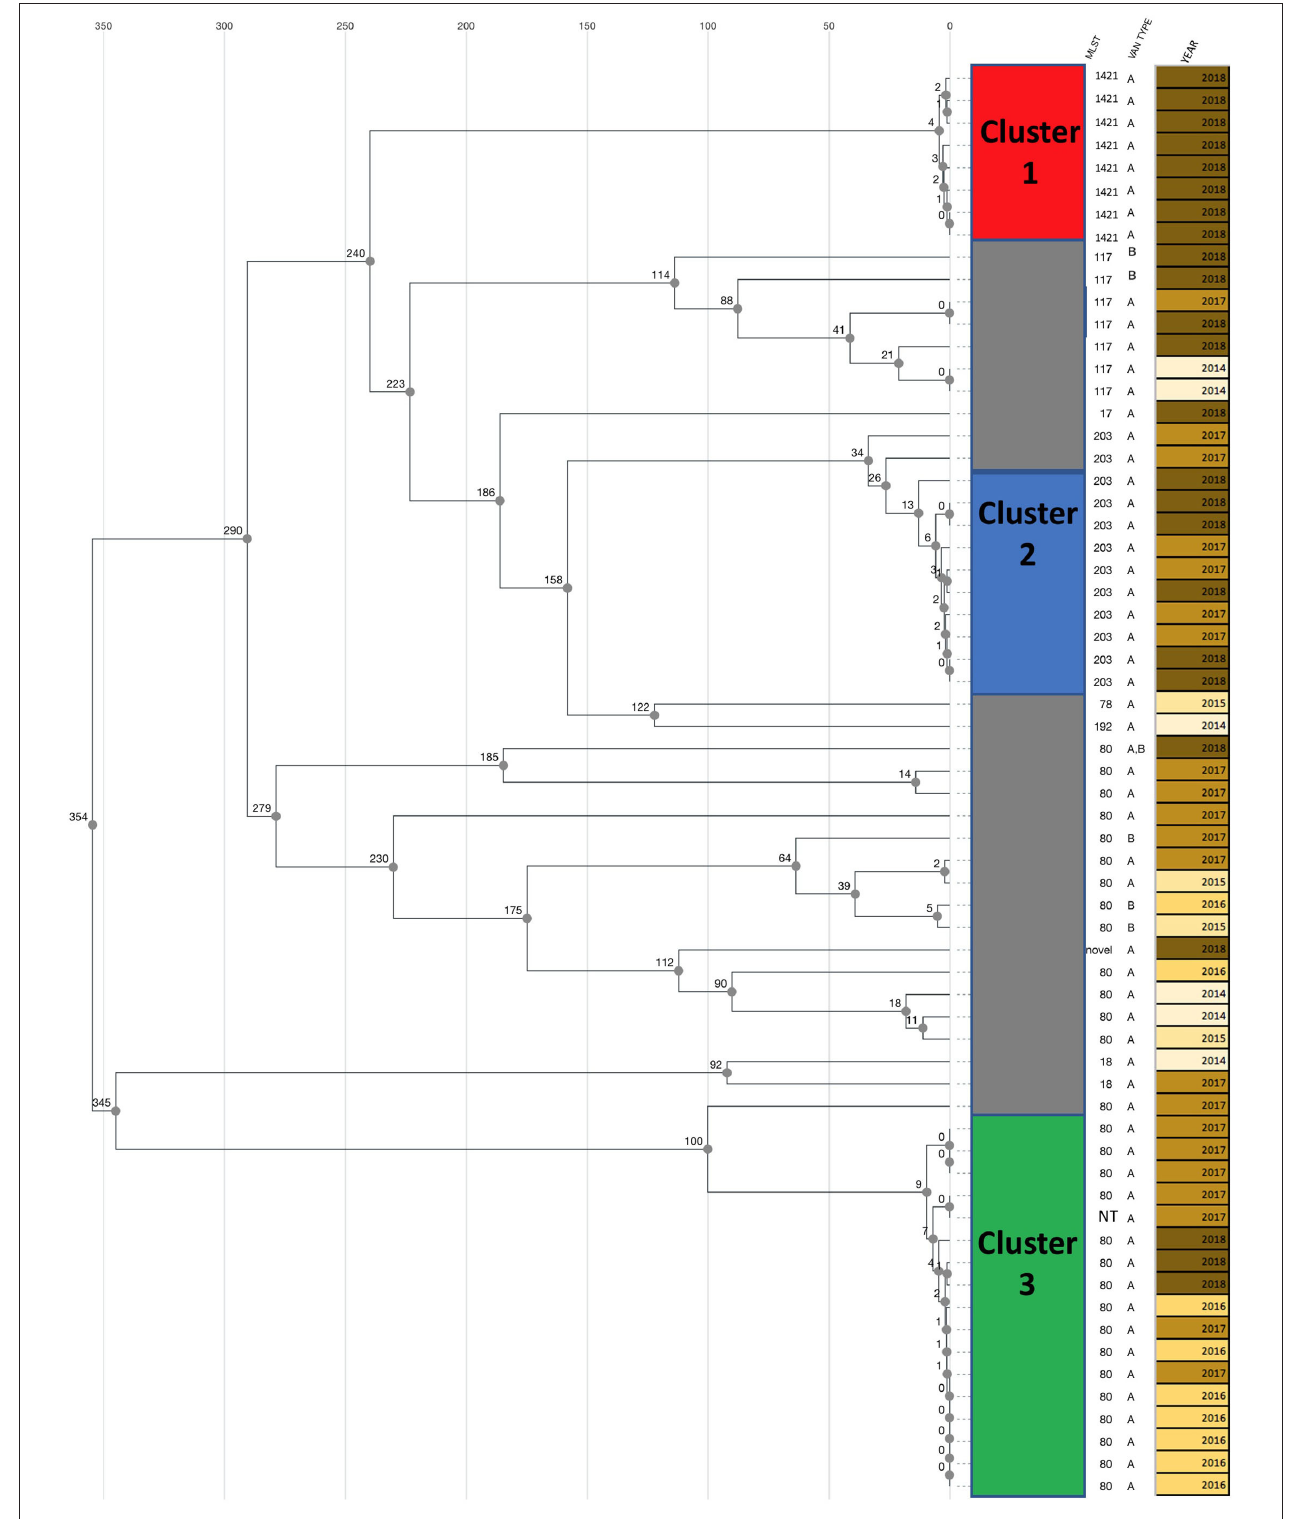
FIGURE 1 | cgMLST based UPGMA clustering dendrogram of clinical (non-screening) E. faecium carrying resistance genes to vancomycin isolated 2014–2018 isolated at a large university hospital. Three clusters of genetically related isolates were identified. The number of allelic differences between individual isolates are indicated at each node. The MLST sequence type and the van gene ( vanA or vanB gene) is indicated for each isolate next to the dendrogram. One isolate was not typable (NT). One isolate carried both vanA and vanB gene. Year of isolation is indicated for individual isolates.